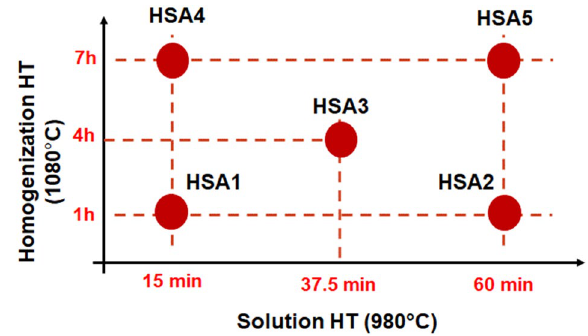
Figure 2. Schematic drawing shows the time window of post heat treatment conducted in the present study.